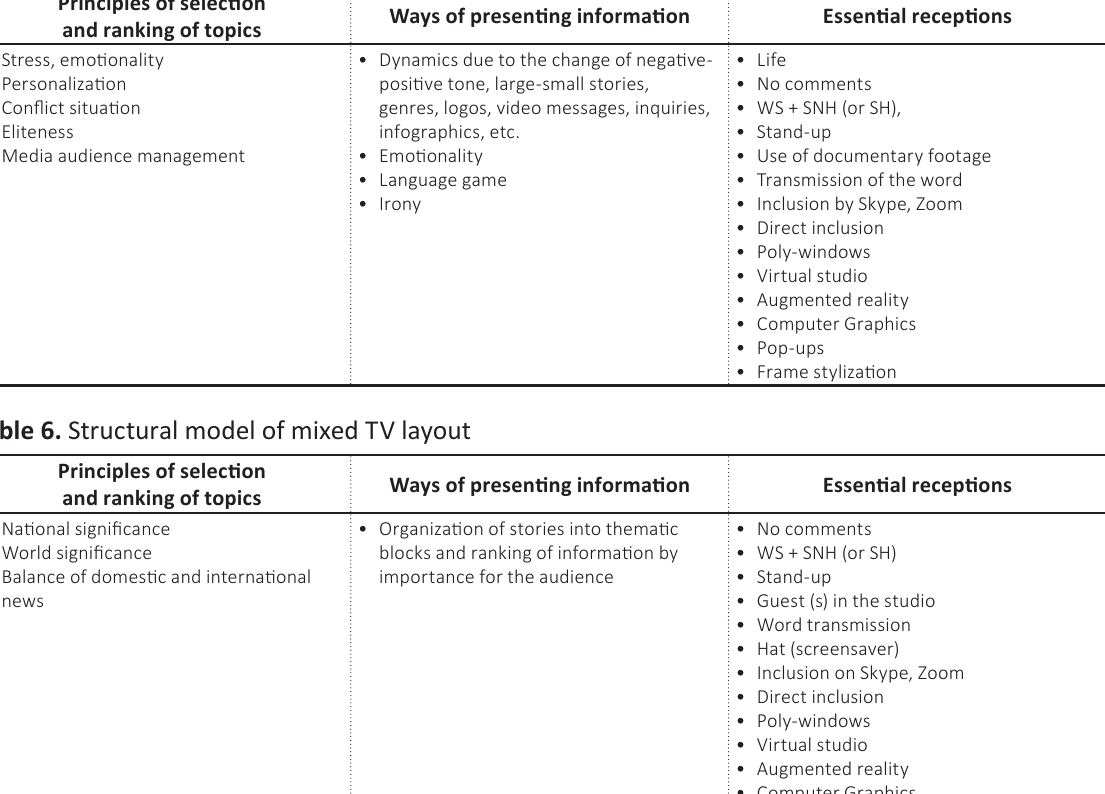
Table 5. Structural model of stress TV layout Principles of selection and ranking of topics